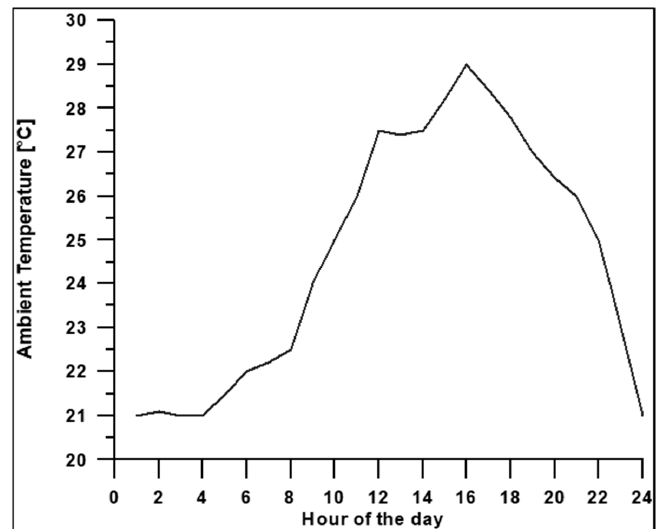
Figure 2. Hour-to-hour ambient temperature variation on 5th July [29].